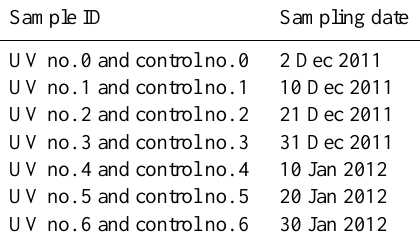
Table 1. Sample IDs with their respective sampling dates during the Austral summer 2011/2012 field campaign at Dome C,